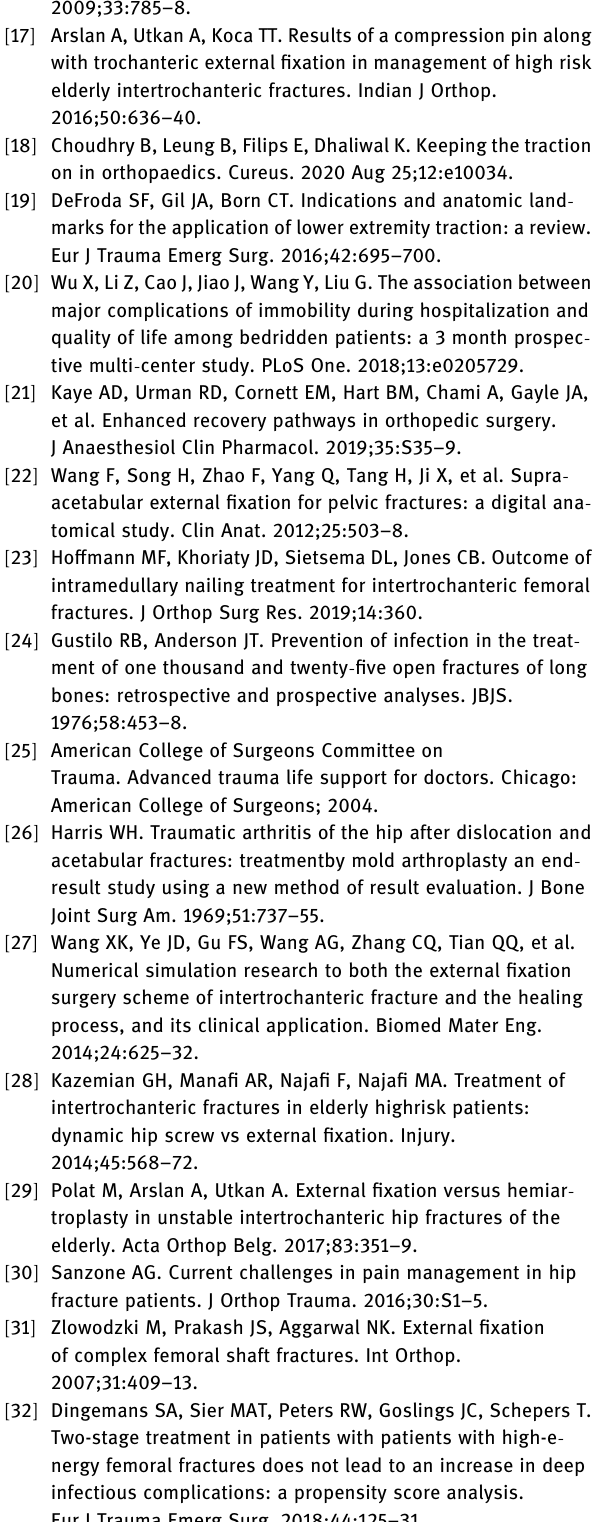
a ff airs hospitals: a comparative e ff ectiveness study. J